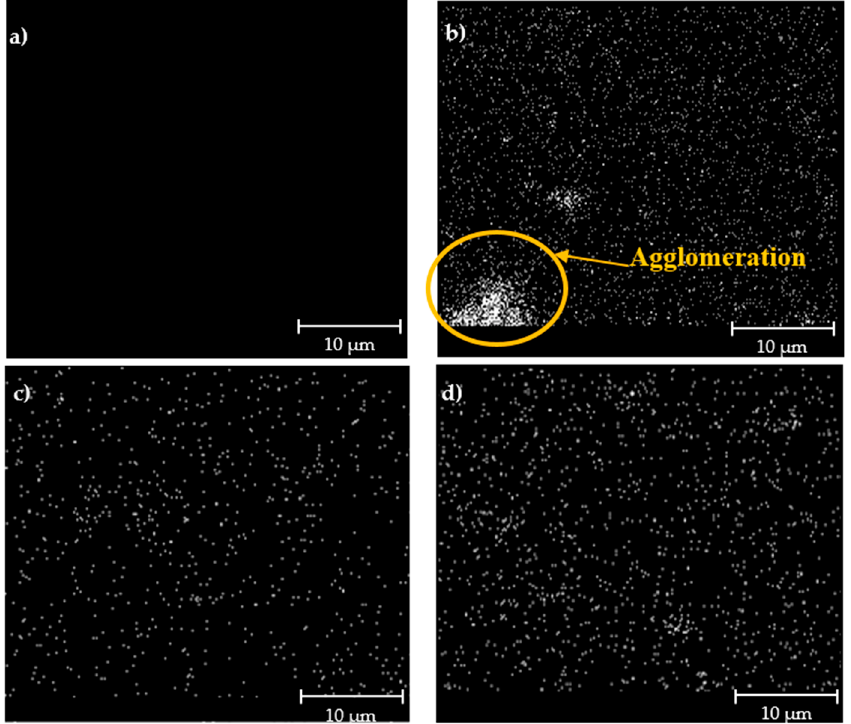
Figure 4. EDX-mapping images of ( a ) pure 6FDA-derived polyimide membrane, and impregnated Linde T ( b ) M1 ( c ) M2, and ( d ) M3 hybrid membranes.